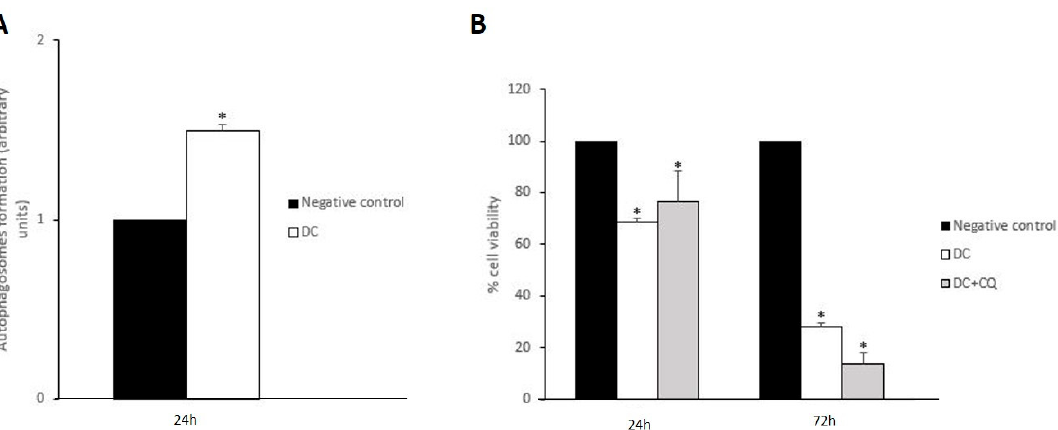
Figure 3. Analysis of autophagy induction. ( A ) Measurement of changes in the formation of autophagosomes on Caco-2 cells 24 h after incubation with DC. * p < 0.05 vs negative control. ( B ) Measurement of cell viability of Caco-2 cells upon 24 h and 72 h treatment with drug combination (DC) in presence / absence of chloroquine (10 µ M, 1 h pre-incubation); * p < 0.05 vs negative control. No significant changes were observed in comparison to cells DC with / without CQ.